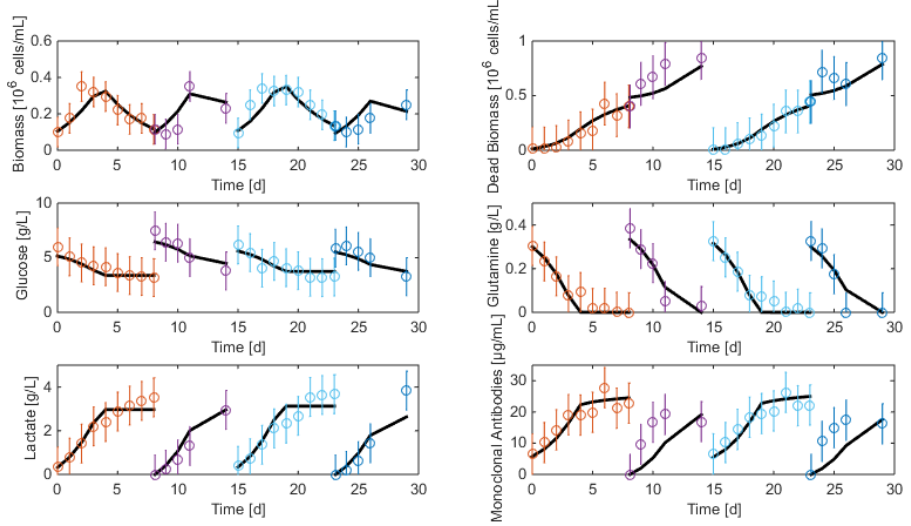
Figure 5. Direct validation of Model (11) on the first two data sets of the HB1 strain. The second experiment starts after 15 days. The solid line represents the model prediction while the circles represent the experimental measurements with a confidence interval at 99%.